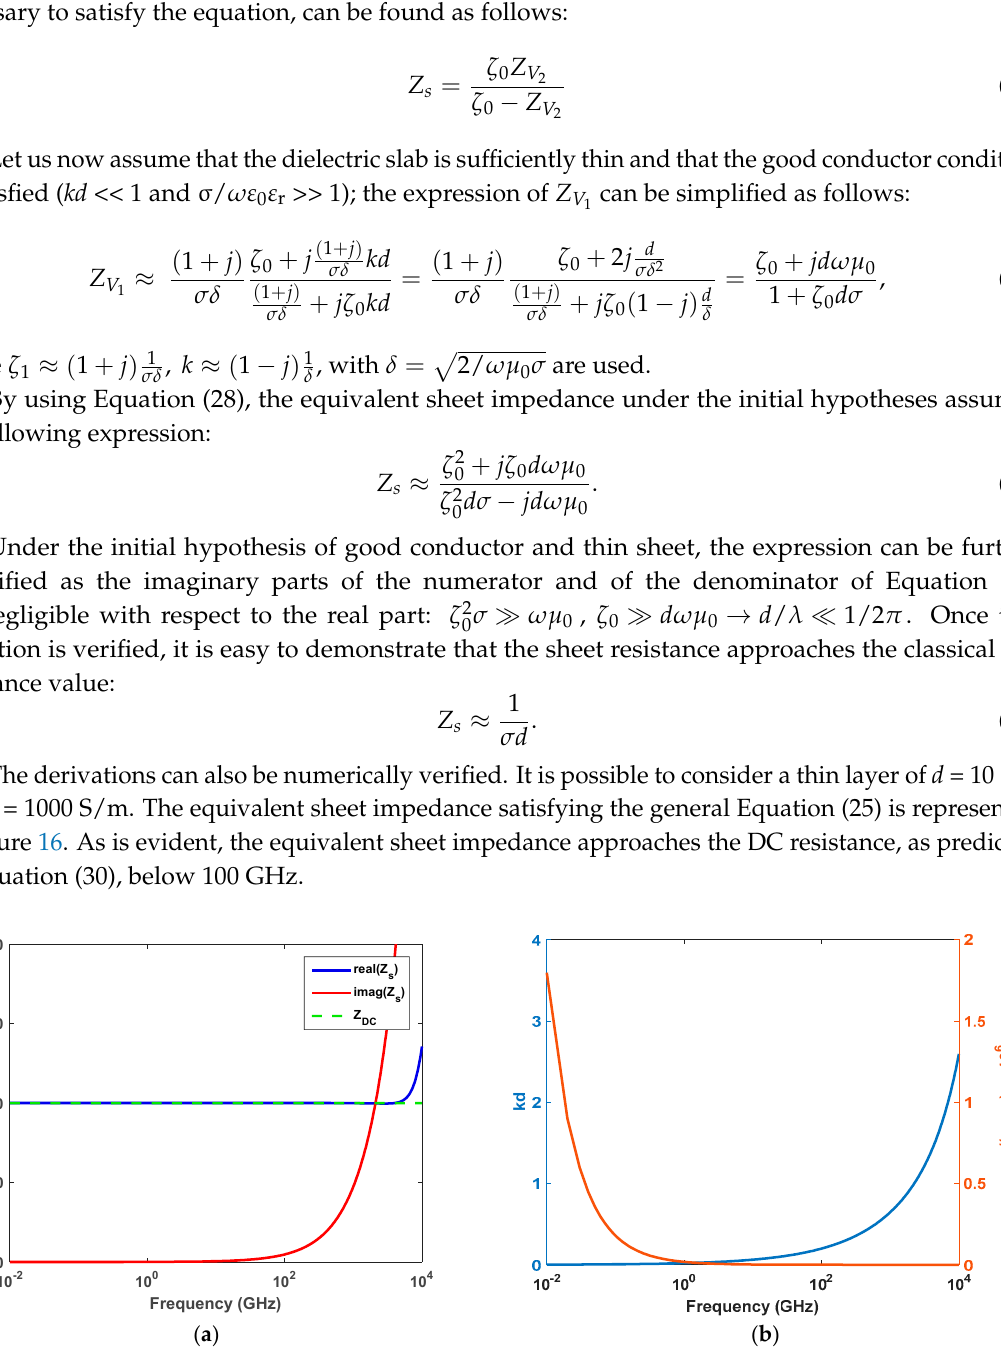
Figure 16. ( a ) Equivalent surface impedance to verify the equivalence of the thin sheet with a finite dielectric conductivity (Figure 15b) and the infinitesimally thin sheet characterised by a lumped impedance (Figure 15a). ( b ) Behaviour of the kd term and the good conductor condition as a function of frequency.